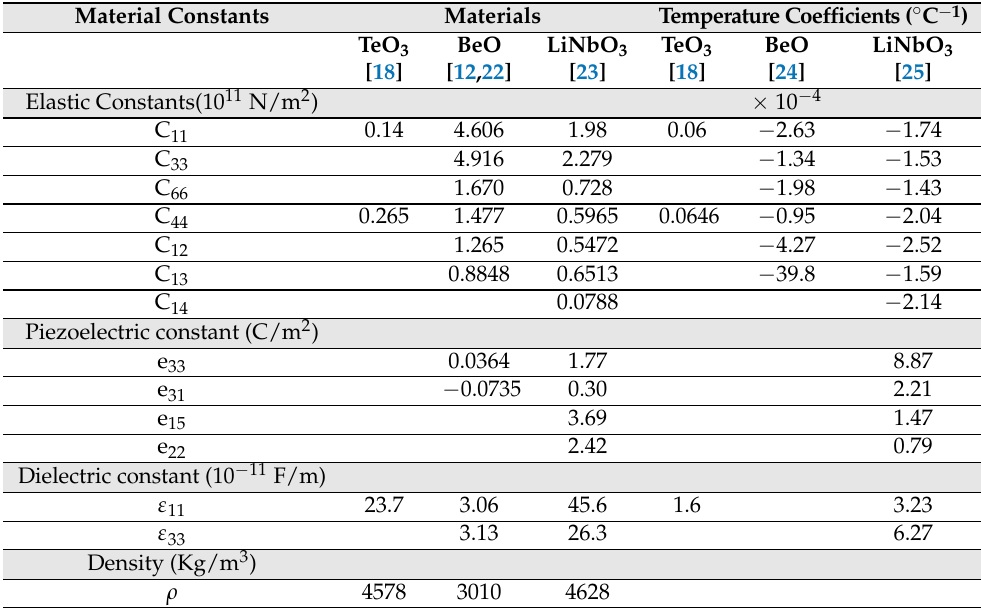
Table 1. Material constants and temperature coefficients used in